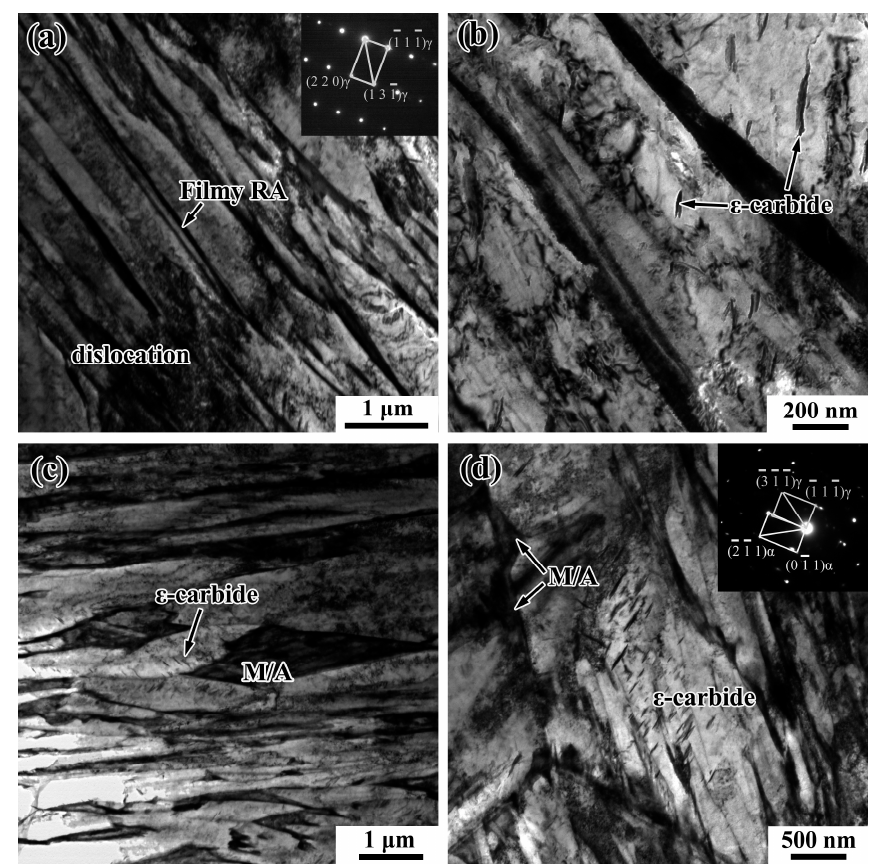
Figure 4. Transmission electron microscope (TEM) of samples at the positions of 5 mm and 15 mm below rail tread treated by T280 process: ( a , b ) T280-P5; ( c , d ) T280-P15.